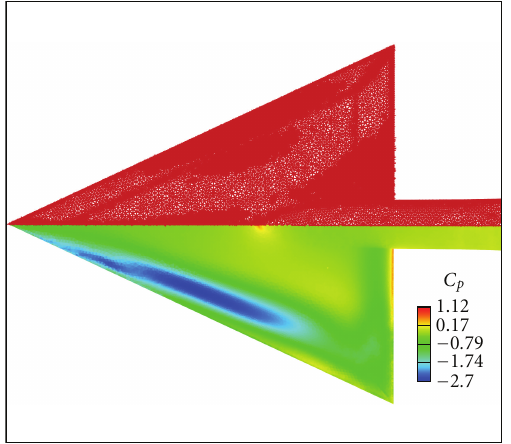
Figure 9: Adapted upper surface mesh and Euler inviscid solution on the sharp leading-edge delta wing at M ∞ = 0 . 4, α = 20 . 3 ◦ .